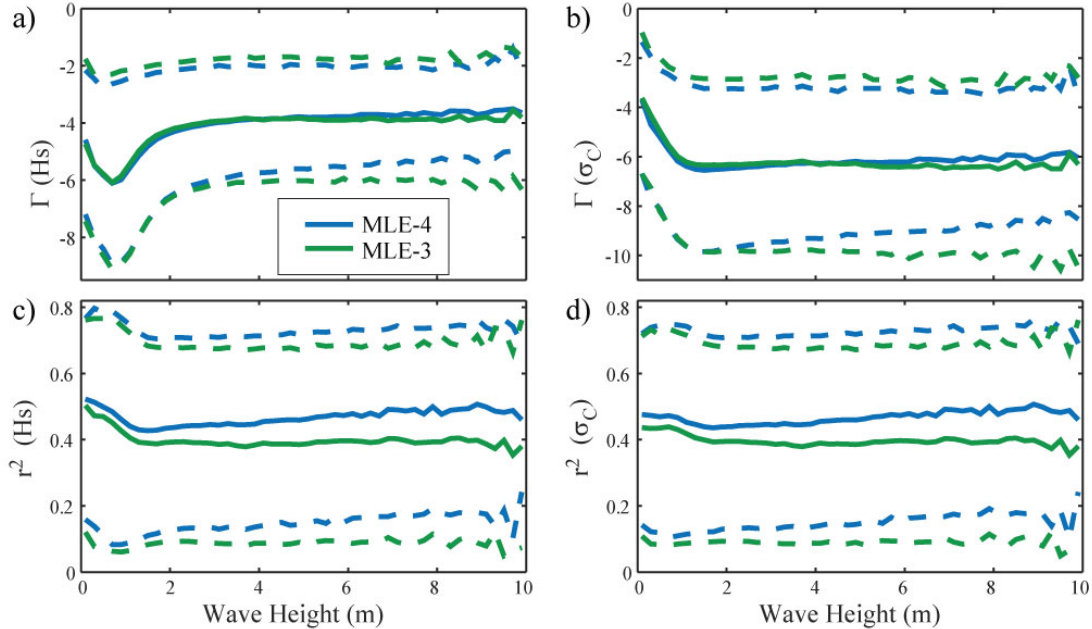
Figure 3. Statistics on the intra-1-Hz covariance of range and wave height anomalies as a function of wave height. ( a ) Proportionality constant, Γ . ( b ) Derived Γ when using σ C as the dependent variable. ( c ) r 2 statistic, showing fraction of Hs variance explained. ( d ) Same for σ C . In all cases, the data are sorted into 0.2 m wide bins, and the solid line shows the median relationship whilst the dashed lines are the 5th and 95th percentiles, indicating the spread of individual